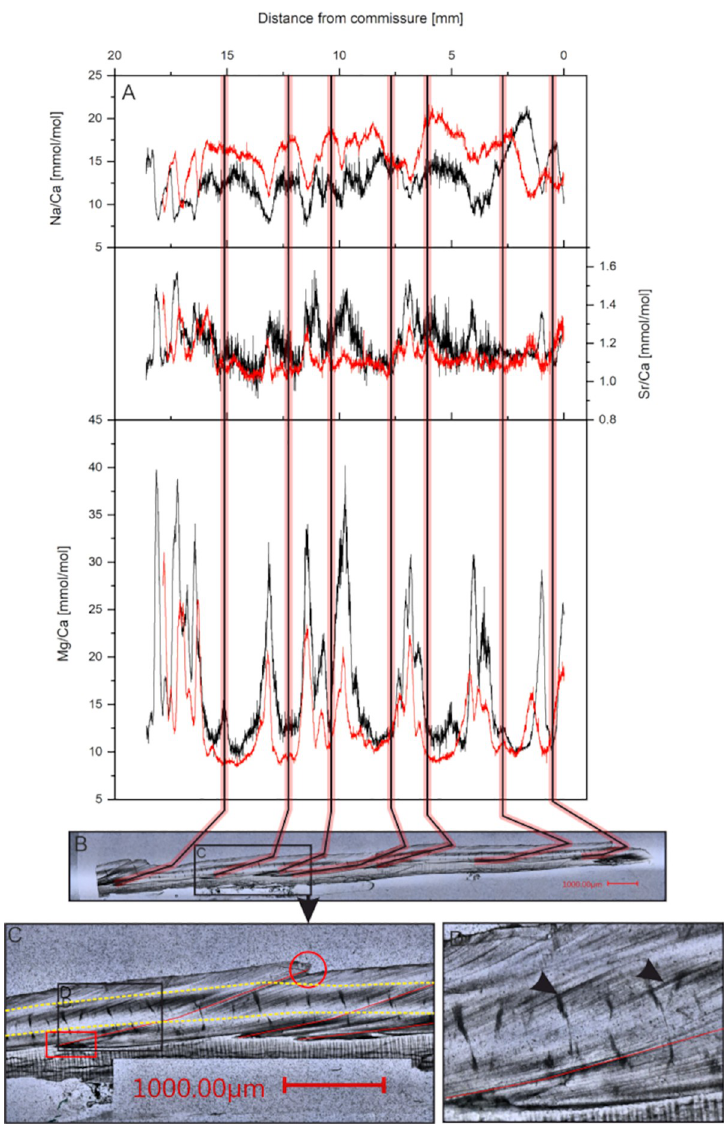
Fig 5. Light microscope and fluorescent microscope images of sample 6R. Magnification = 25X, H3 filtercube, ¼ s exposure time. Scale bar is 1 mm.